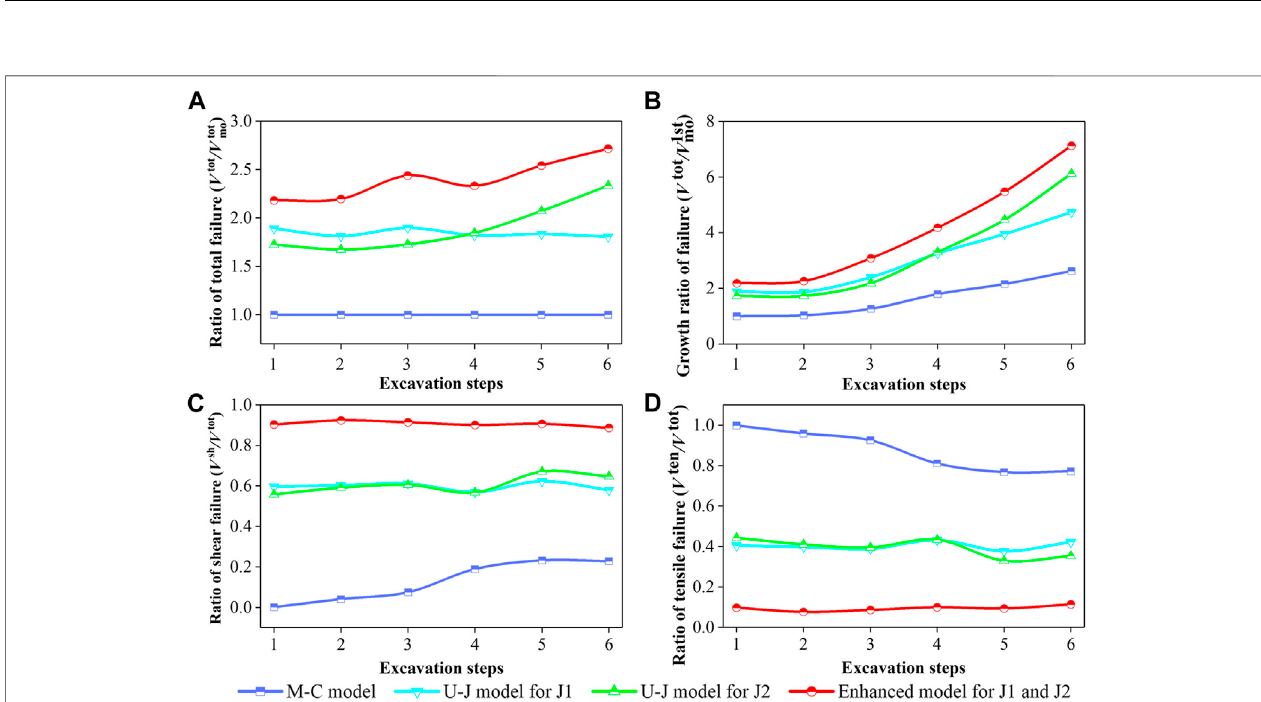
FIGURE 10 | Comparison of (A) the volume ratios of total plastic zones ( V tot / V tot mo ), (B) the growth ratios of plastic zone volumes ( V tot / V 1st mo ), (C) the volume ratios of shear failures ( V sh / V tot ), and (D) the volume ratios of tensile failures ( V ten / V tot ) at each excavation step. V tot is the total failure volume (including volumes of shear and tensile failures); V tot mo is the total failure volume calculated using M – C model; V 1st mo is the failure volume calculated using M – C model at the fi rst excavation step; V sh is the shear failure volume; V ten denotes the tensile failure volume.